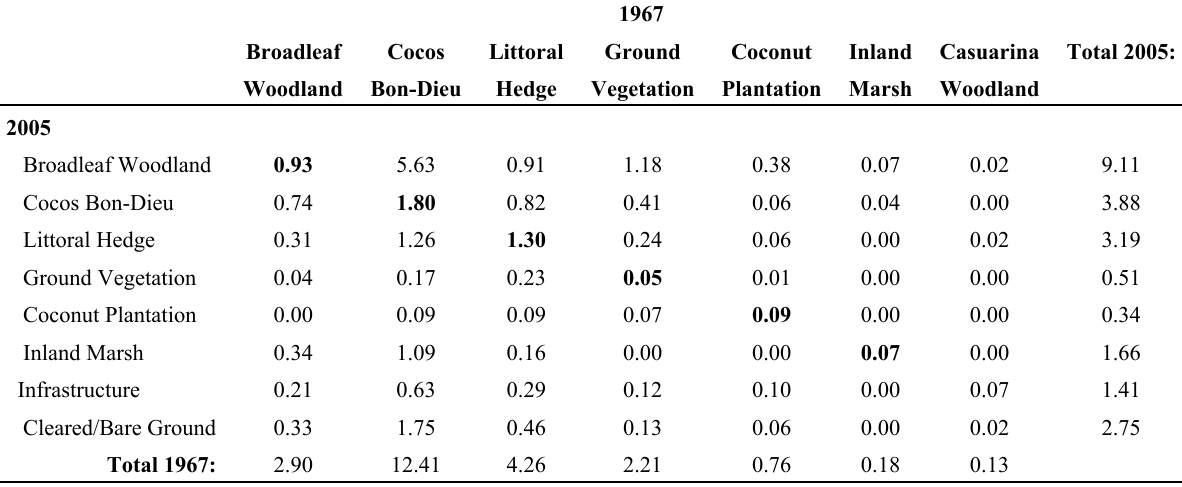
Table 2. A change detection matrix generated from comparing the areas of classes mapped in 1967 and 2005 vegetation maps. Numbers indicate the difference in area mapped for each vegetation category, bold numbers along the diagonal indicate areas mapped consistently (units are in km 2 , cumulative error ±17.6 m 2